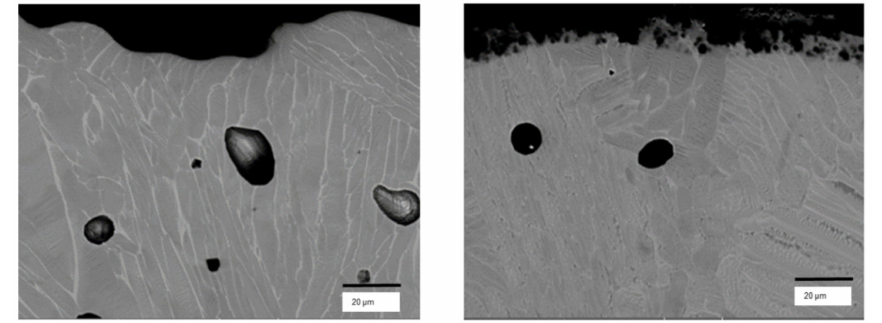
Figure 8. Scanning electron microscopy (SEM) micrographs of the fracture area of the initial Ti64 sample ( left ) and Ti64 sintered with Mg alloy after Mg degradation ( right